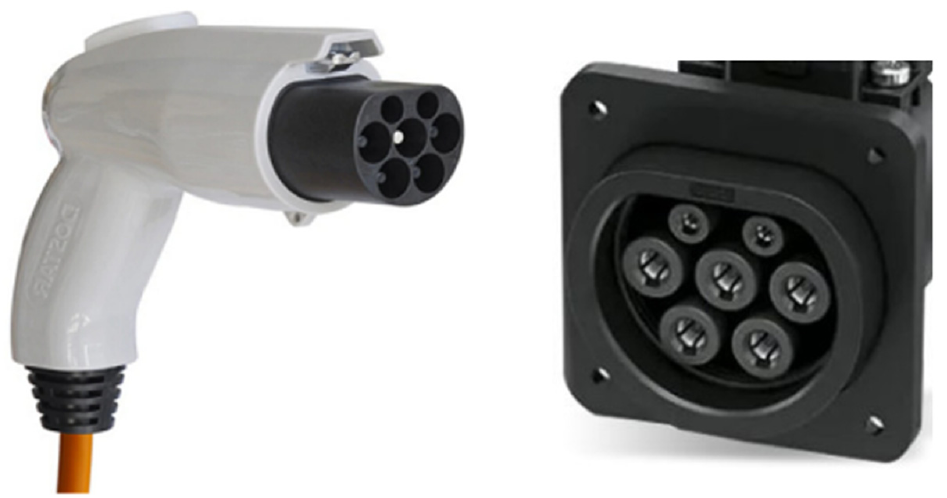
Figure 21. The GB/T AC charging coupler: EV Plug ( Left ) and Inlet ( Right ).